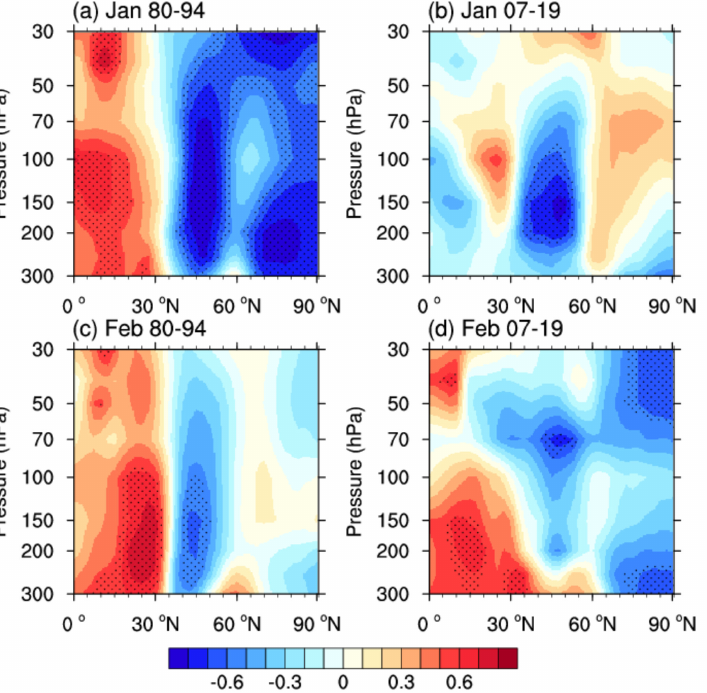
Figure 5. Correlation coefficients between the AO index and zonal mean ozone concentrations from 300 to 10 hPa over the Northern Hemisphere in ( a , b ) January and ( c , d ) February during ( a , c ) 1980–1994 and ( b , d ) 2007–2019. Values over the stippled regions are statistically significant at the 95% confidence